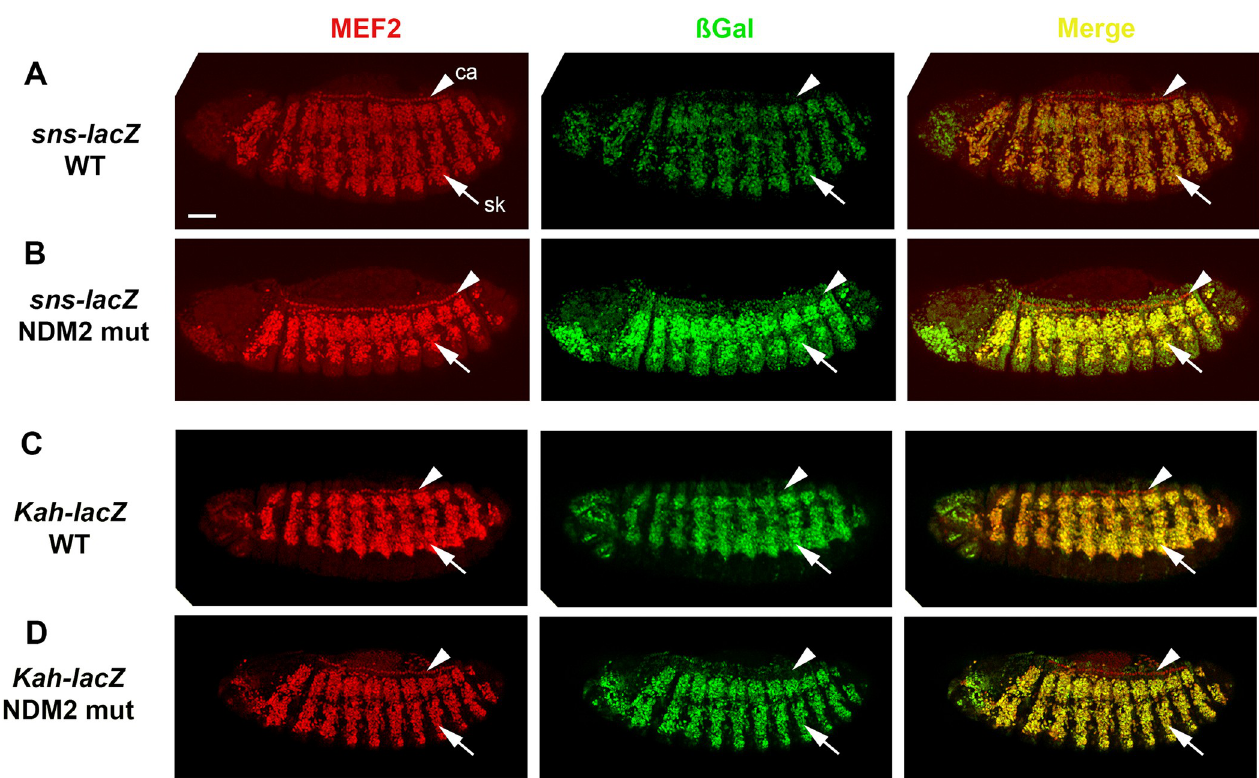
Fig 4. NDM2 is dispensable for the activity of two myoblast-specific promoters. Stage 13 embryos are shown stained for accumulation of MEF2 as a marker of mesodermal cells (red), and ßGal as a reporter for expression of the indicated promoter- lacZ transgenes (green). Arrows indicate skeletal muscle myoblasts that express the lacZ reporter (sk), and arrowheads indicate cardiac cells (ca) that are ßGal-negative. Bar, 75 μ m.